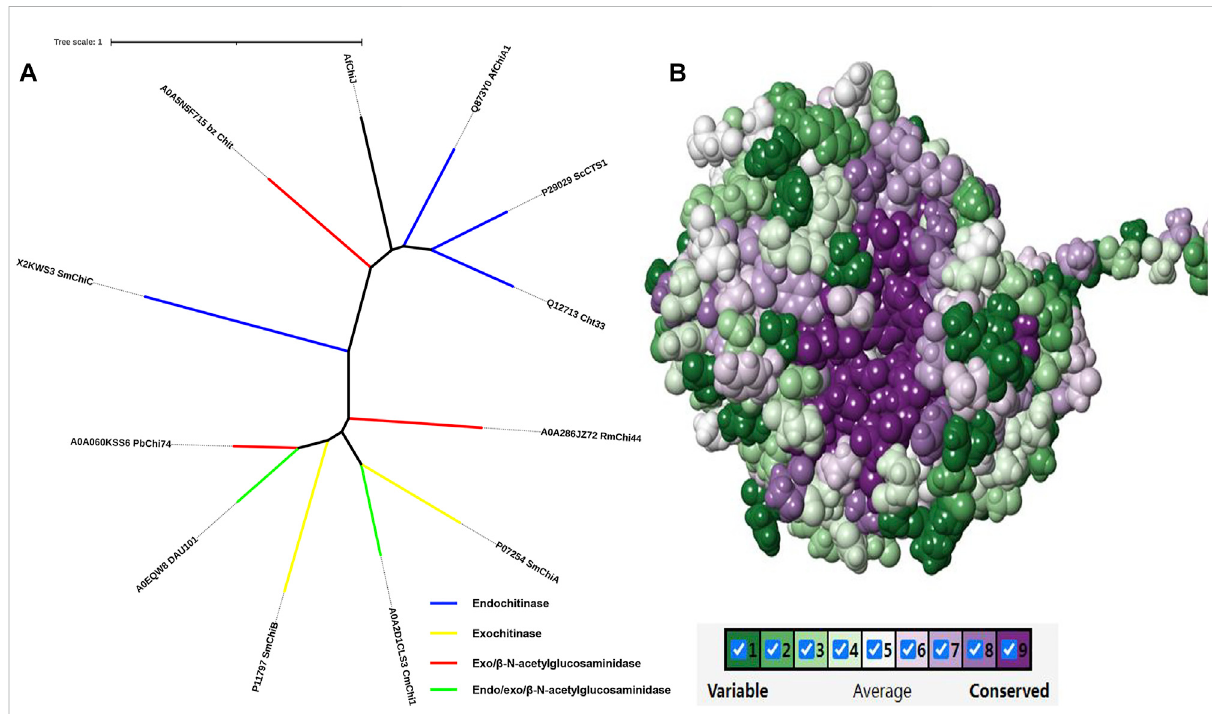
FIGURE 9 Phylogenetic tree analysis and evolutionary analysis of Af ChiJ. (A) The phylogenetic tree analysis of Af ChiJ. The endochitinases are shown in blue, exochitinases are shown in yellow, exo and β -N-acetylglucosaminidases are shown in red, endo/exo and β -N-acetylglucosaminidases are shown in green. Tree scale: 1 substitution per nucleotide position. (B) The evolutionary conservation is determined based on the structure and multiple sequence alignment. The amino acid residues are colored ingredient representing the conservation grades from the most variable (turquoise) to the most conserved (maroon) obtained with ConSurf